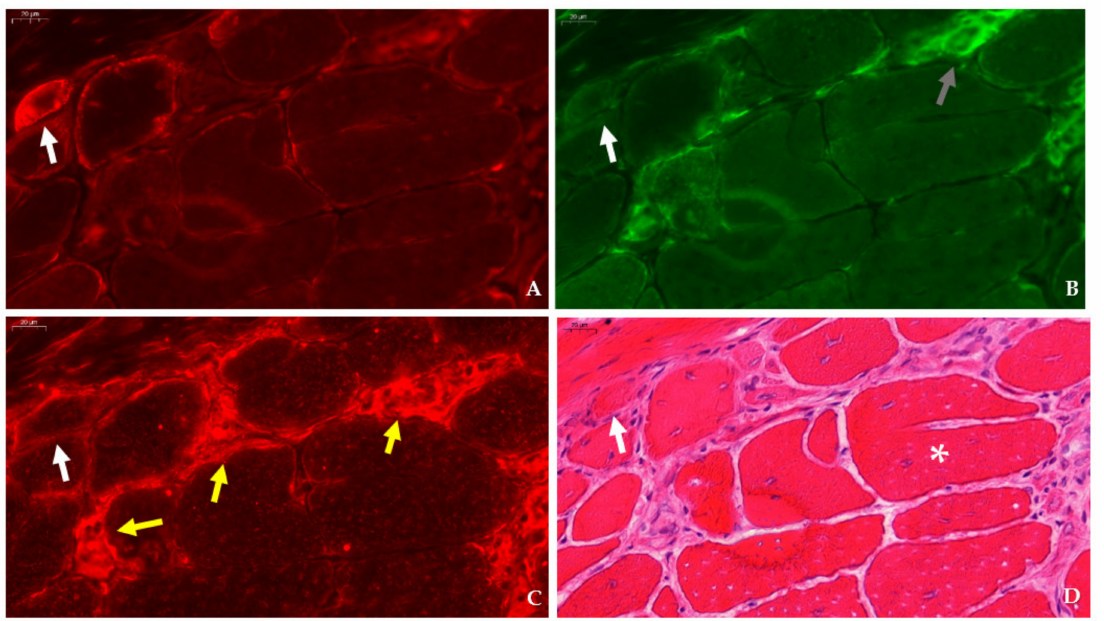
Figure 7. Expression of betaine GABA transporter (BGT) in relation to dystrophinopathy-associated pathology in consecutive sections of the tibialis anterior in a 12 week-old mdx mouse. ( A ) BGT (CY3, red) is expressed in a few myofibers (arrow). ( B ) F4/F80 positive macrophages (AlexaFluor 488, green, grey arrow) does not necessarily localize with BGT-positive myofibers (white arrow). ( C ) Staining of the consecutive section with CD206 antibody (CY3, red, yellow arrows) does not convincingly localize to the BGT-positive fiber (white arrow) observed in panel A. ( D ) After double staining with BGT/F4F80, this section was re-stained with H&E. The arrow indicates the BGT-positive fiber in panel A, whereas the asterisk shows a splitting fiber. Scale bars = 20 µ